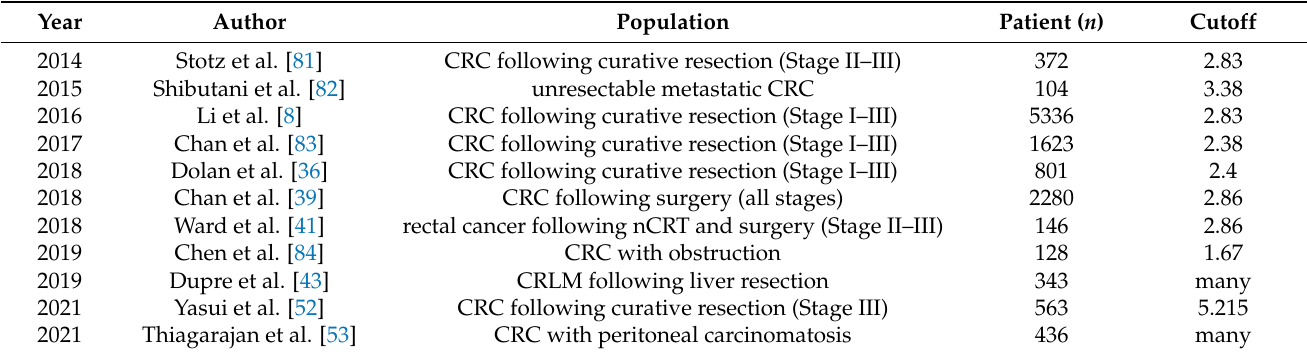
Table 4. Lymphocyte–monocyte ratio (LMR) in previous reports on colorectal